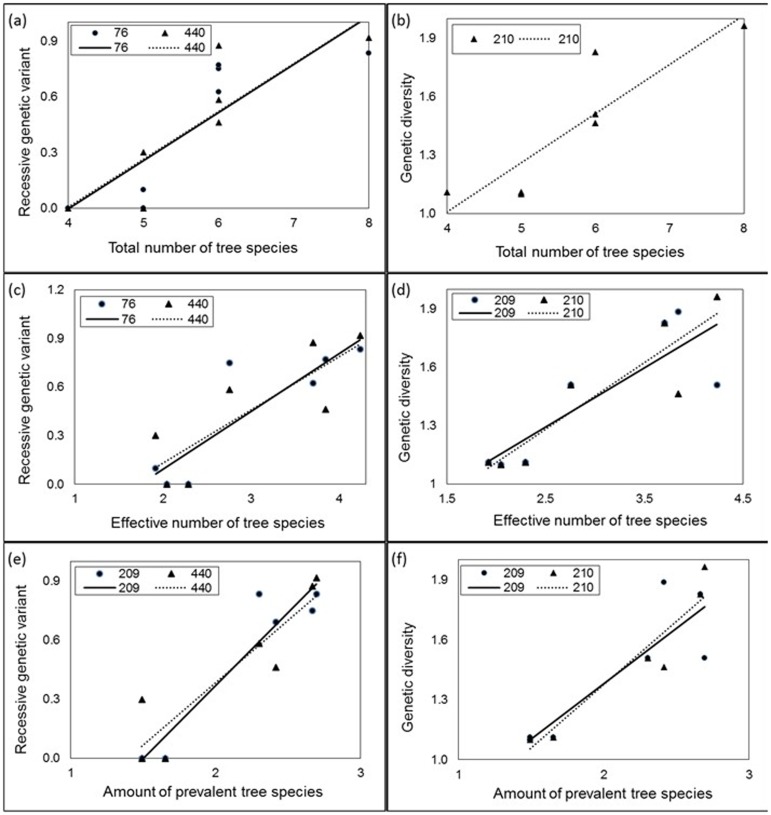
Graphs showing how species diversity (νsp,a) is related to recessive genetic variant (fvr) and genetic diversity (νg,2) at putative adaptive AFLPs in Populus tremuloides in the Picea chihuahuana tree community.